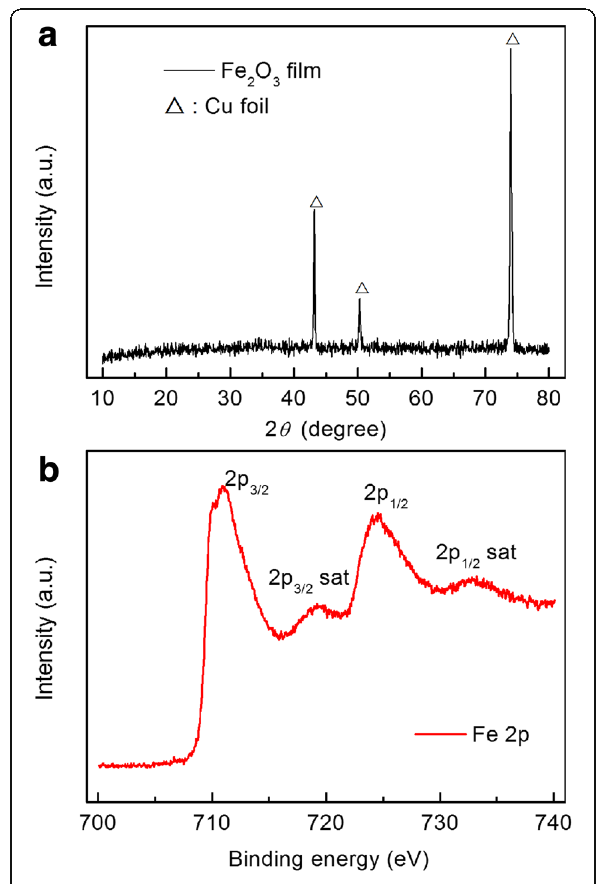
Fig. 1 Structure and composition characterization of Fe 2 O 3 film deposited at room temperature. a XRD patterns of Fe 2 O 3 film. b XPS spectrum of Fe 2 O 3